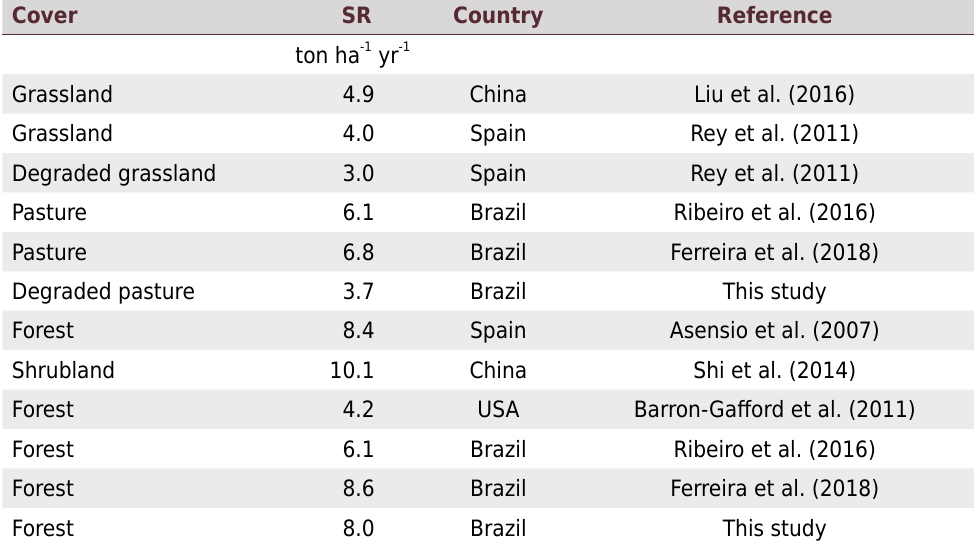
Table 4. Overview of annual soil respiration (SR) in grassland, pasture, shrubland, and forest ecosystems in semiarid regions Cover SR Country Reference ton ha -1 yr -1 Grassland 4.9 China Liu et al. (2016) Grassland 4.0 Spain Rey et al. (2011) Degraded grassland 3.0 Spain Rey et al. (2011) Pasture 6.1 Brazil Ribeiro et al. (2016) Pasture 6.8 Brazil Ferreira et al. (2018) Degraded pasture 3.7 Brazil This study Forest 8.4 Spain Asensio et al. (2007) Shrubland 10.1 China Shi et al. (2014) Forest 4.2 USA Barron‐Gafford et al. (2011) Forest 6.1 Brazil Ribeiro et al. (2016) Forest 8.6 Brazil Ferreira et al. (2018) Forest 8.0 Brazil This